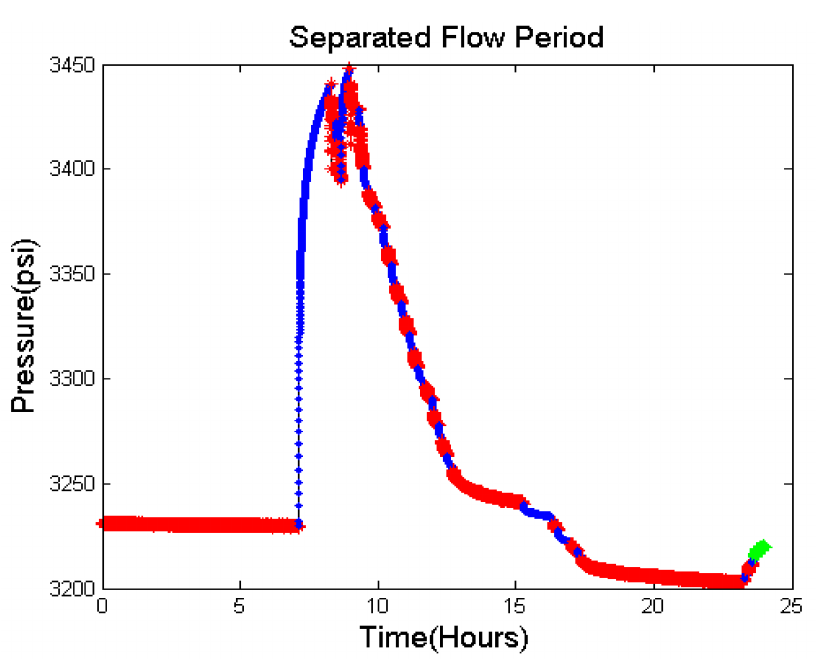
Figure 4. Detection result using the data grouping method from Li